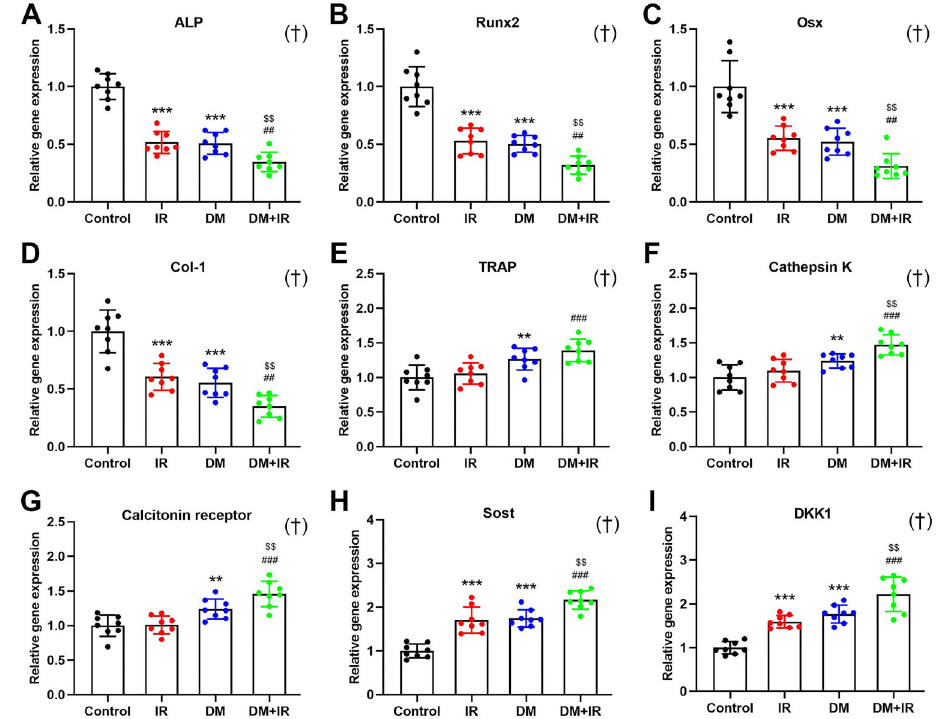
Figure 5. Effects of focal irradiation on skeletal relative gene expression levels of ( A – D ) osteoblast-related markers (ALP, Runx2, Osx, and Col-1), ( E – G ) osteoclast-related markers (TRAP, Cathepsin K, and Calcitonin receptor), and ( H – I ) Wnt inhibitors (Sost and DKK1) in the mid-diaphysis of the right femur in streptozotocin-treated diabetic rats and non-diabetic rats. Data are reported as means ± SD (n=8). **P o 0.01, ***P o 0.001 vs the Control group; ## P o 0.01, ### P o 0.001 vs the IR (irradiated) group; $$ P o 0.01 vs the DM (diabetic) group; w interactions between DM and IR